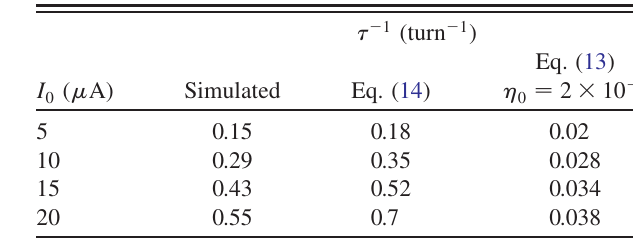
1 : 5 cm as a function of the beam current. The curve y ¼